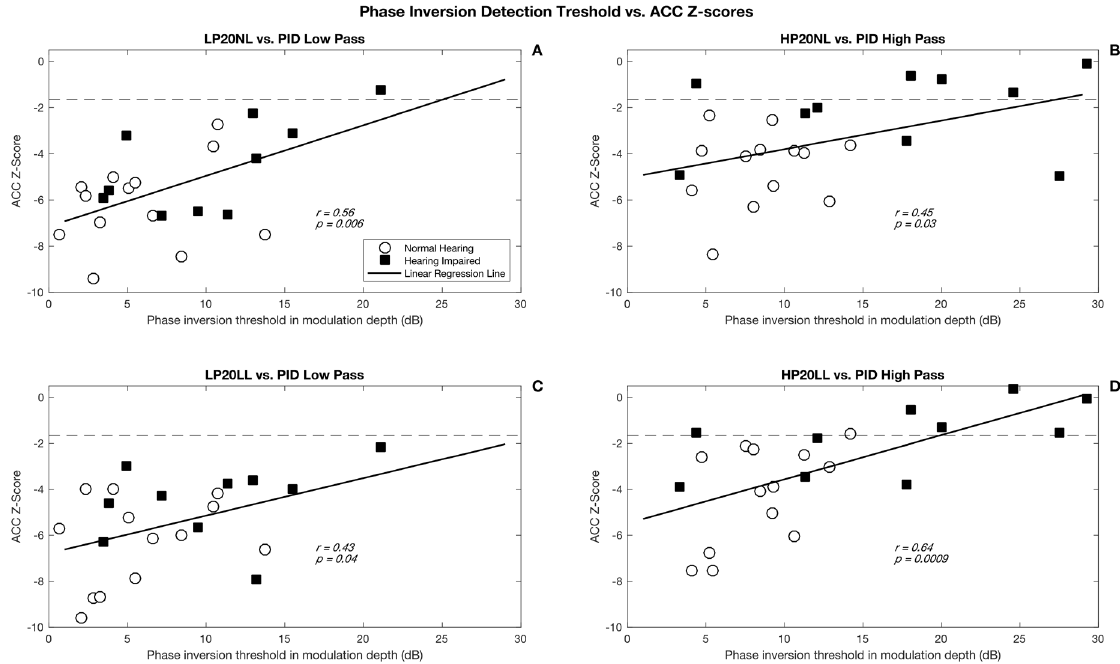
Figure 2. Correlation between PID thresholds (dB) and ACC z-scores for 4 stimuli. Panel ( A ) shows results for the low-pass filtered stimuli presented at normal conversational level (LP20NL), panel ( B ) shows results for the high-pass filtered stimuli presented at normal conversational level (HP20NL), panel ( C ) shows results for the low-pass filtered stimuli presented at low level (LP20LL), and panel ( D ) shows results for the high-pass filtered stimuli presented at low level (HP20LL).